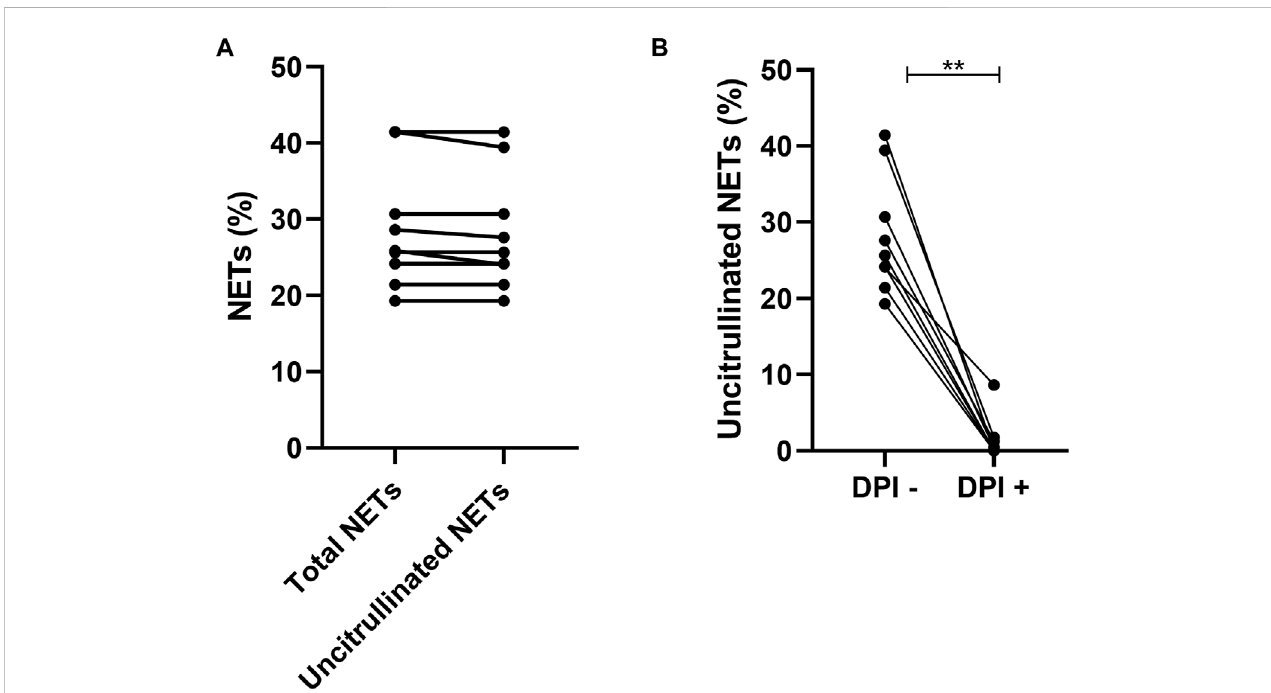
FIGURE 3 Comparison of total NETs (25.85% [22.83; 36.07]) and uncitrullinated NETs (25.65% [22.75; 35.06]) after induction by PMA p = 0.25 (A) . Comparison of uncitrullinated NETs after induction by PMA without inhibition by DPI (25.65% [22.75; 35.06]) and with inhibition by DPI (0.00% [0.00; 1.53]) p = 0.003 (B) . Results are represented with their medians and interquartile ranges [Q1; Q3]. PMA: phorbol-12-myristate-13-acetate. DPI: diphenyleiodonium.** p < 0.01.